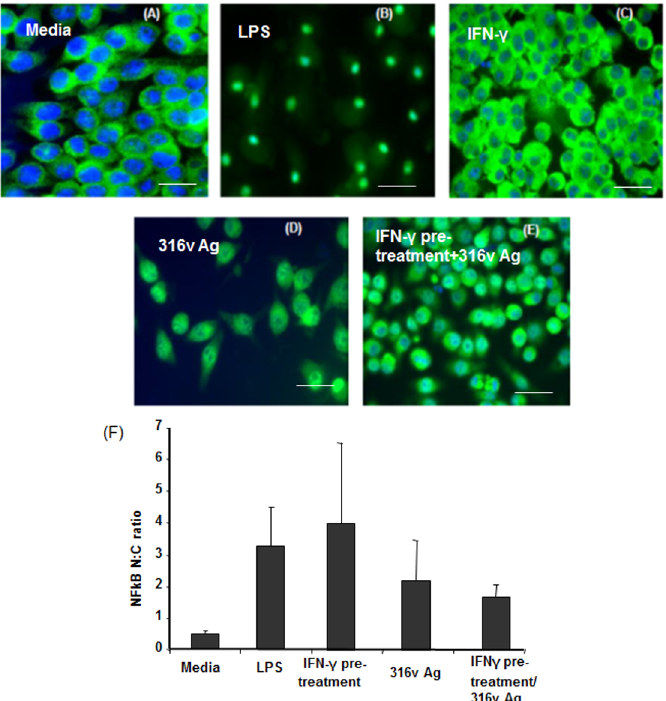
Fig 2. Effect of IFN- γ pre-sensitization on macrophage NF κ B activation and translocation in response to MAP 316v antigen. RAW 264.7 cells were incubatedfor one hour with media (A) LPS (100 ng/mL) (B), IFN- γ primingalone (C), 316v Ag (100 μ g/mL) without any pre-treatment (D) or 316v Ag (100 μ g/mL) after pre- treatment with IFN- γ (100 ng/mL) for 30 minutes (E). The cells were stainedfor NF κ B by immunofluorescence and images were captured using a fluorescence microscope. Image analysisand quantification was performed using using Image ProPlus ® software (F). Data is representative of triplicate treatments of one out of two